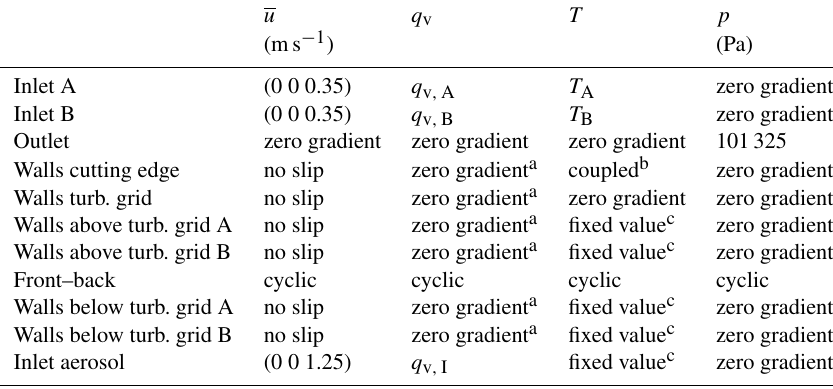
Table 2. Boundary conditions for LES. u q v T p (ms − 1 ) (Pa) Inlet A (0 0 0.35) q v , A T A (0 0 0.35) q v , B T